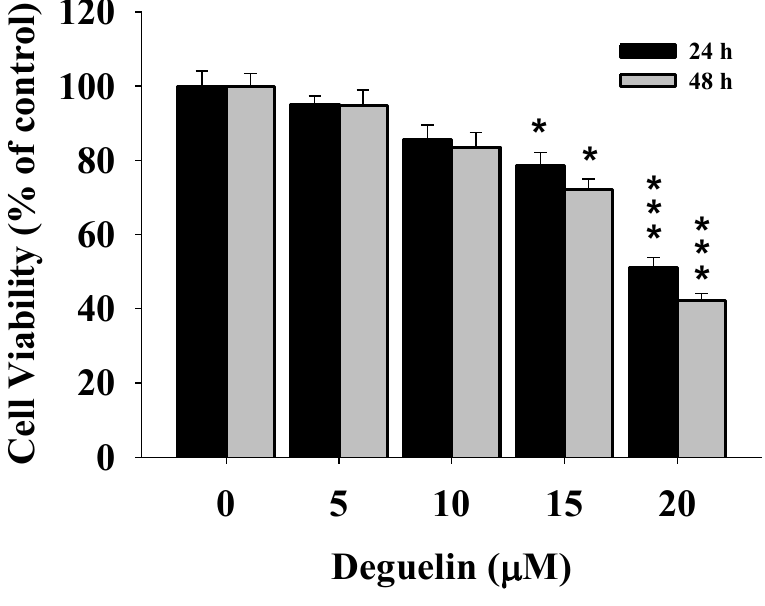
Figure 1. Deguelin affects the percentage of viable U-2 OS human osteosacroma cells. U2-OS cells (2 × 10 5 cells/well) were incubated with 0, 5, 10, 15, and 20 μM of deguelin for 24 h and 48 h. Cell were harvested to determine the percentage of viable cells by flow cytometry as described in the Experimental Section. * p < 0.05, *** p < 0.001, significant difference between deguelin-treated groups and the control as analyzed by Student’s t